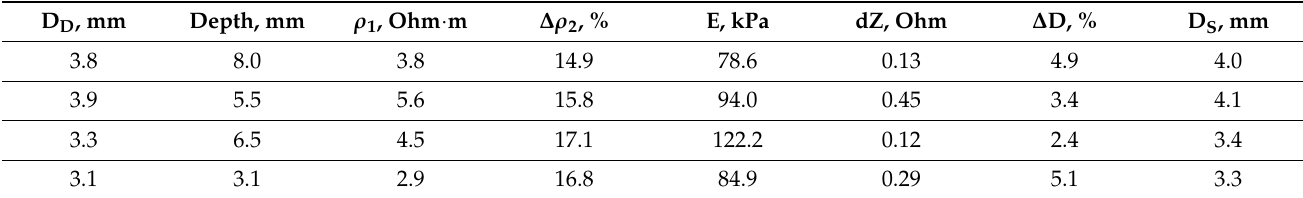
Table 3. The obtained results from experimental